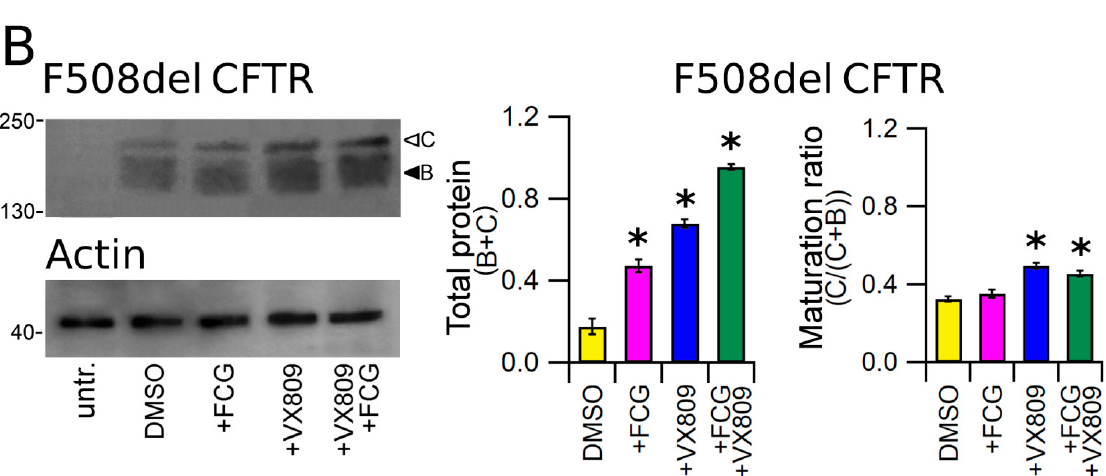
Figure 1. Detection of full-length CFTR proteins by Western blot. Detection of WT ( A ) and F508del CFTR ( B ) in lysates of untransfected and transiently transfected HEK-t cells treated with DMSO (control), FCG, VX809, and FCG + VX809 is shown in the upper panels on the left. Expression of the housekeeper protein actin in the same samples is shown in the lower panels. The molecular weight of the proteins of the molecular weight marker that was run in the SDS-PAGE is indicated on the left of each blot. White and black arrowheads indicate the position of bands B and C, respectively. Bar graphs in the middle show the quantification of total protein expression, calculated as the sum of bands B and C. Bar graphs on the right indicate the quantification of the mature, fully glycosylated fraction of the CFTR protein, expressed as C/(C + B) ratio. The expression level of each band was normalized to the level of actin detected in the same samples. Data are expressed as mean ± standard error of the mean (sem) of at least four independent experiments. Statistical comparison of the data was made by Dunnett’s multiple comparison test (all groups against control group). Asterisks indicate a statistical significance versus control: * p < 0.05.